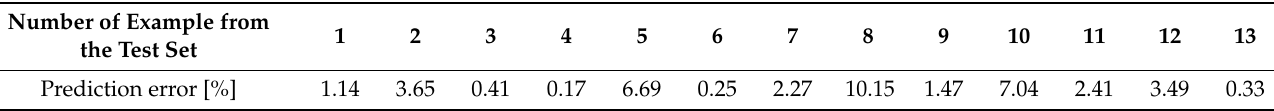
Table 3. Summary of the prediction errors of the developed neural model for the subsequent elements of the test set, determined for the maximum methane seam pressure (see Figure